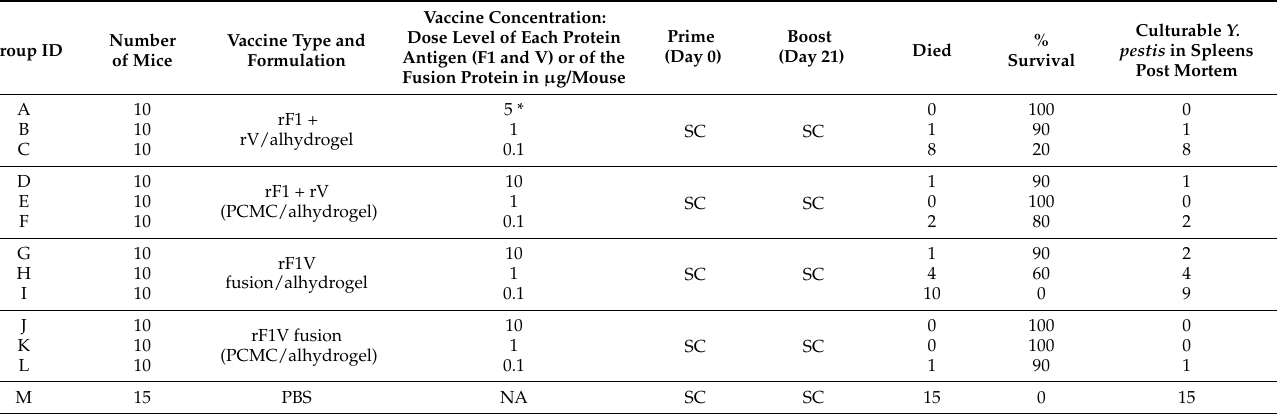
Table 1. Treatment groups and survival